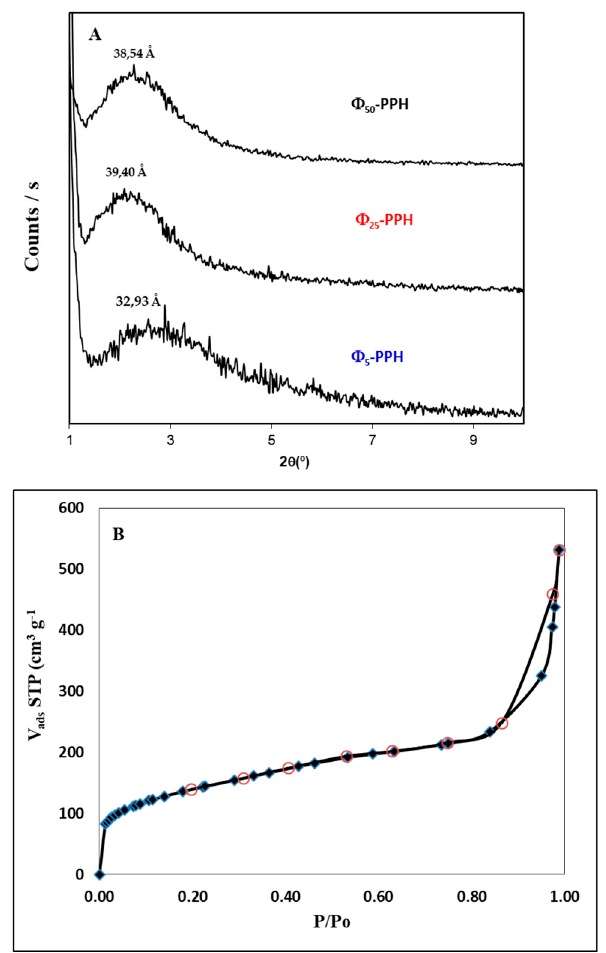
Figure 2. ( A ) XRD pattern of Φ 5 -PPH, Φ 25 -PPH and Φ 50 -PPH; ( B ) N 2 adsorption-desorption isotherms at 77 K of Φ 5 -PPH.